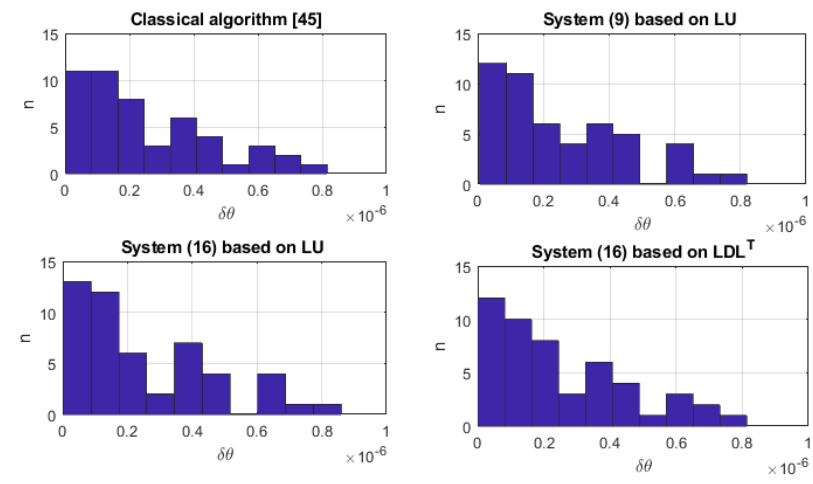
Figure 3. Normalized root mean square error of the parameters [45]. Table 4. The mean values of the condition numbers of the matrices and their standard deviations.